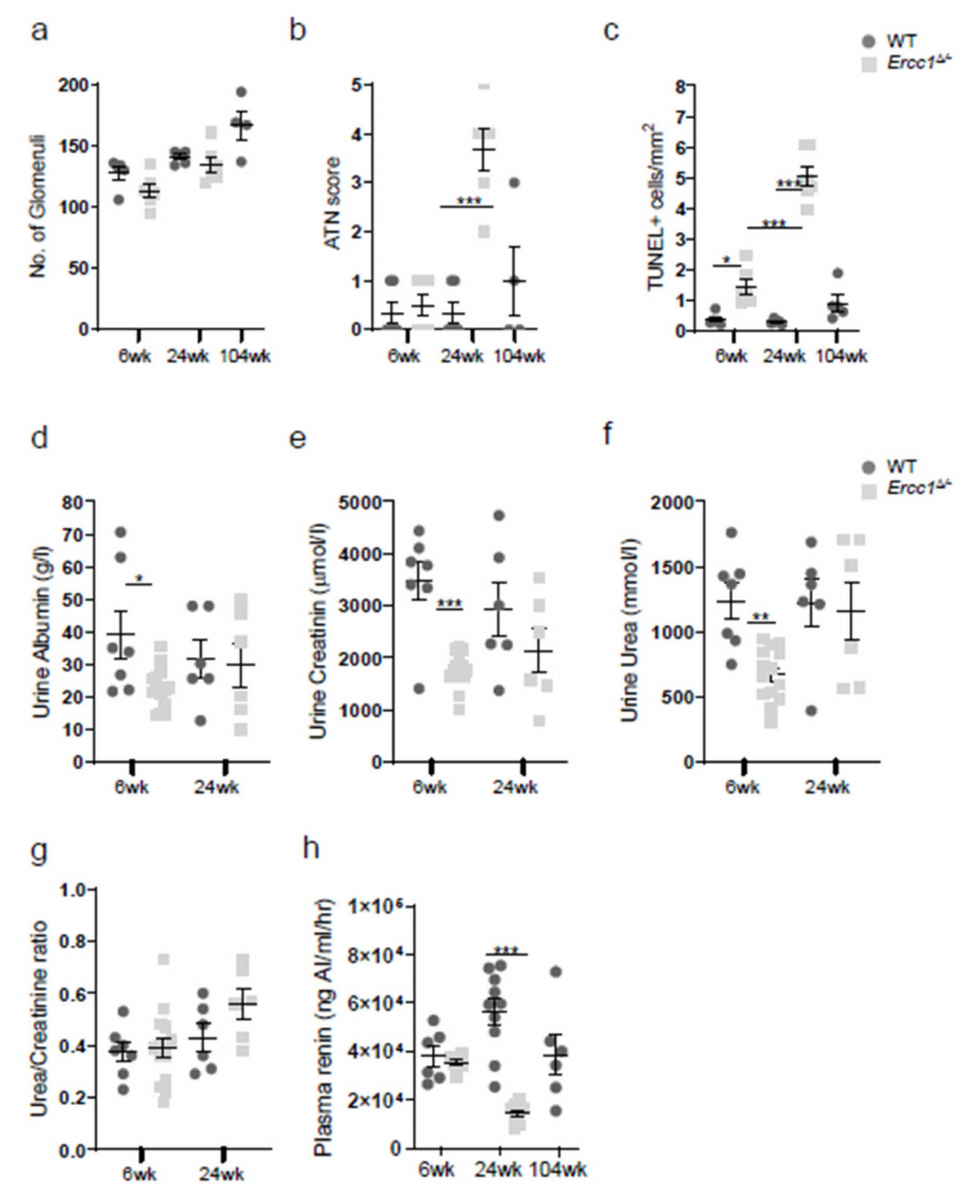
Figure 2. Functional renal changes in progeroid Ercc1 d / − mice. ( a ) The number of glomeruli confirmed normal kidney development from birth in Ercc1 d / − . ( b ) ATN scoring showed significantly increased kidney damage in 24-week-old Ercc1 d / − mice compared to their wild-type (WT) littermates. ( c ). Quantification of TUNEL staining indicated significantly increased apoptotic cell death in Ercc1 d / − kidneys. Urinary albumin ( d ), creatinine ( e ) and urea ( f ) levels were comparable between 24-week-old Ercc1 d / − and WT mice. ( g ) Urea/creatinine ratio showed no significant differences between Ercc1 d / − and WT mice. ( h ) Plasma renin concentration was significantly decreased in 24-week-old Ercc1 d / − mice compared to WT. Data are means ± SEM of n = 4–6 ( a – c ) and n = 6–14 ( d – h ). Note: * p < 0.05, ** p < 0.01, *** p < 0.001 vs.